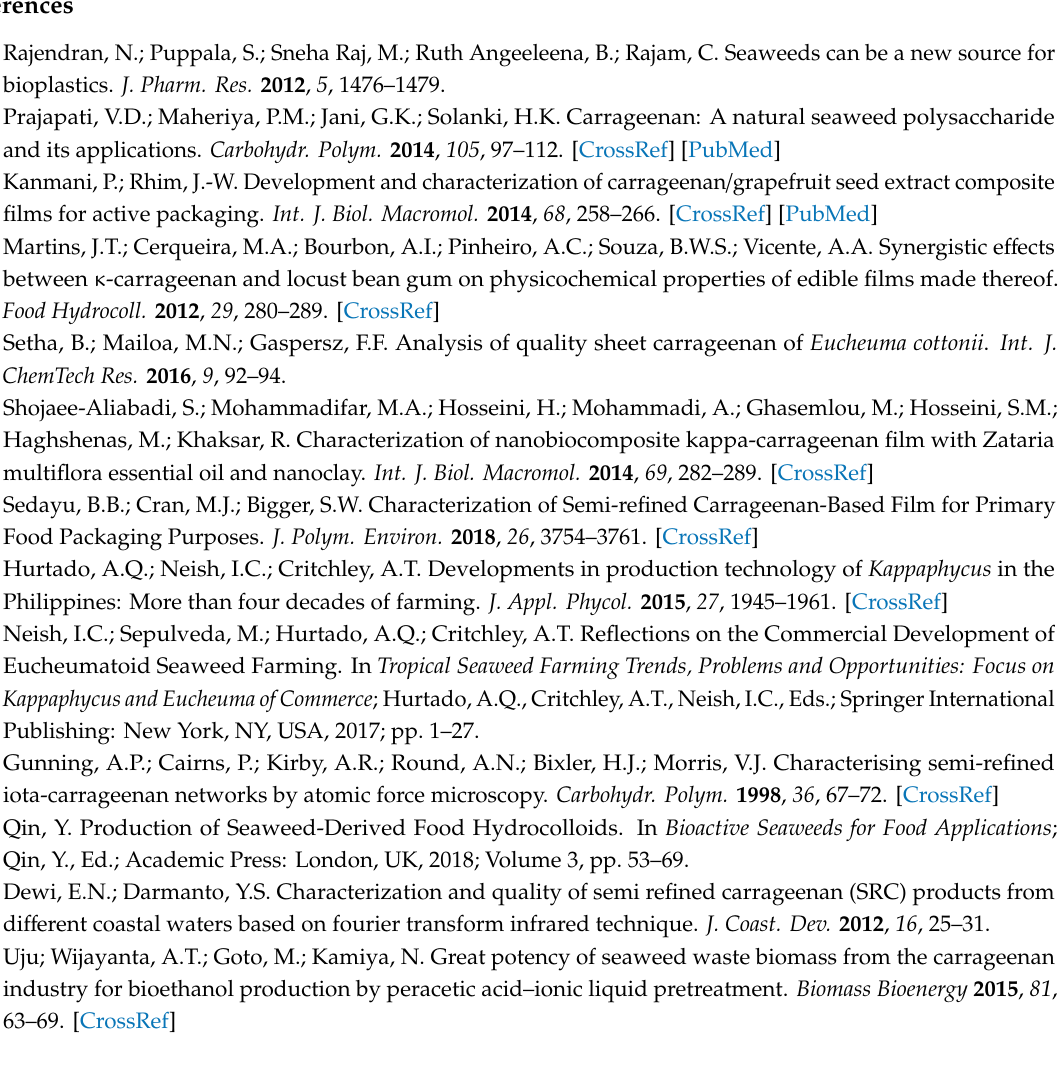
Figure S1: Complete set of TG and dTG thermographs of SRC / NCF and RC / NCF films, Table S1: Data obtained from the TG decomposition profiles of the SRC and RC films, Figure S2: DSC thermographs of SRC and RC powder, Table S2: Data obtained from the DSC thermograms of the SRC / NCF and RC / NCF films, Table S3: Degree of crystallinity of SRC / NCF and RC / NCF films, Figure S3: FTIR spectra of the SRC / NCF films, Figure S4: FTIR spectra of the RC / NCF